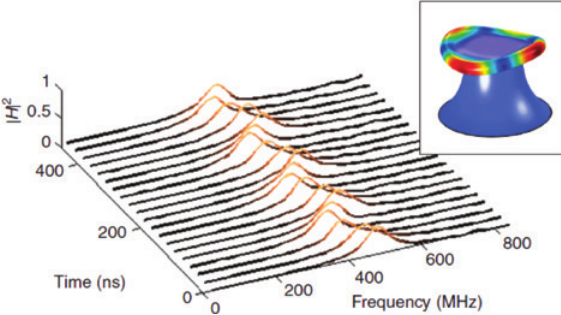
Figure 7: Cavity ring-up spectroscopy for ultrafast sensing with optical microresonators.